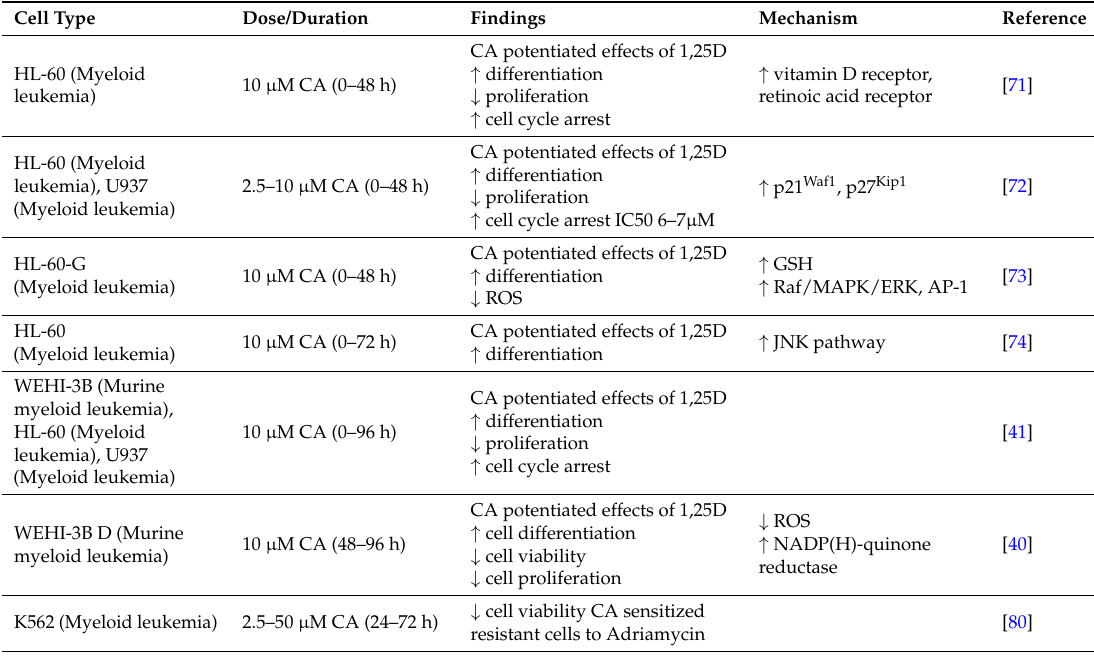
Table 11. Anticancer effects of Carnosic Acid (CA). In vitro studies: